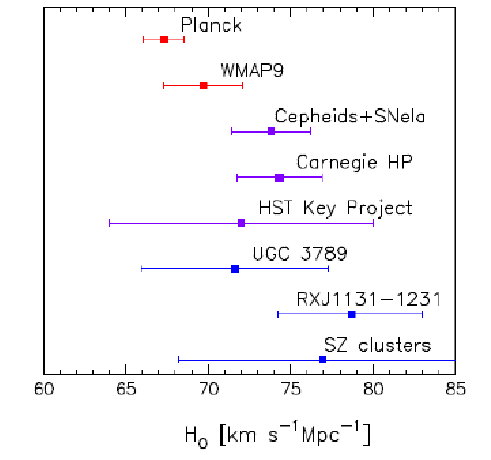
Figure 1: Reproduced from Ref. [6] The tension of the H 0 value between HST key project (Cepheid+SNe Ia) and the CMBR anisotropy fit, shown in fig. 1, that was marginal ( − 1 . 2 σ ) with